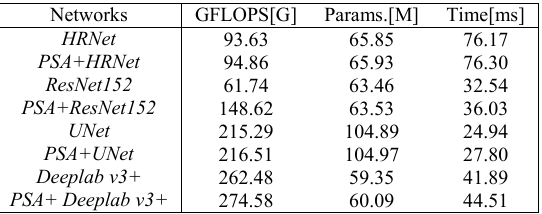
Table 4. The cost of all models. Figure 13. Examples for classification results on the ISPRS Vaihingen dataset, images marked with a are the input images, and b , c , d , e , f , g , denote the ground truth labels, results of the baseline ( ResNet152 ), and corresponding results applied with PSA, LKPP, SENet, Non-local , respectively. Corresponding colors for land cover classes are listed in Tab. 5.